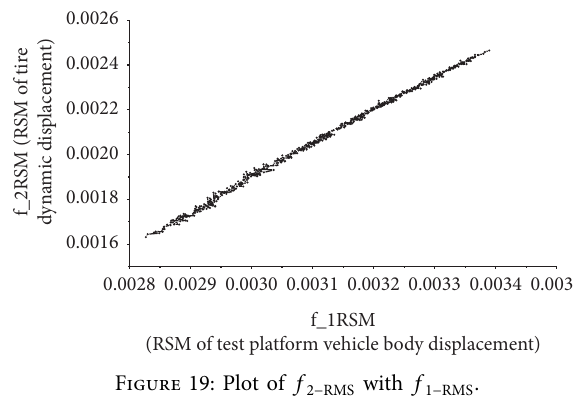
with f . 2 − RMS 1 − RMS